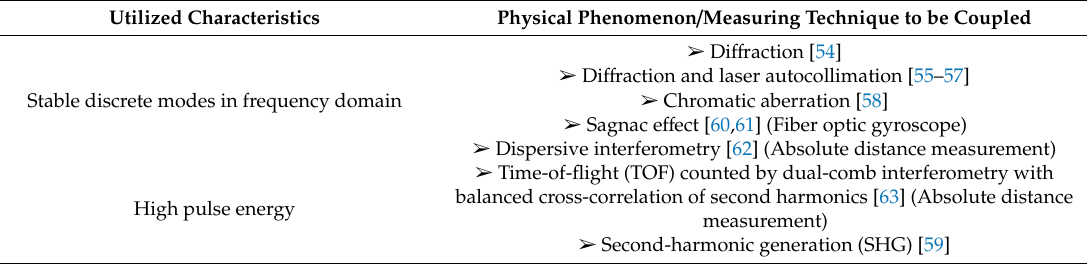
Table 1. Optical angle sensors based on a mode-locked femtosecond